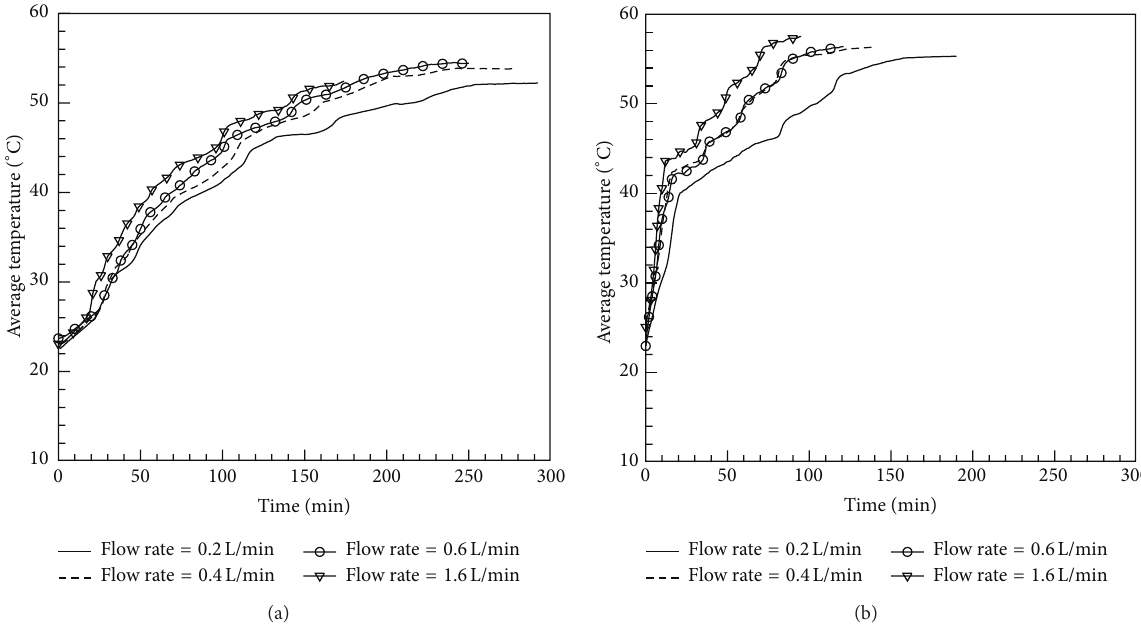
Figure 6: Comparison of average temperature profile in the PCM at various mass flow rates in charging process: (a) simple heat exchanger; (b) finned-tube heat exchanger.